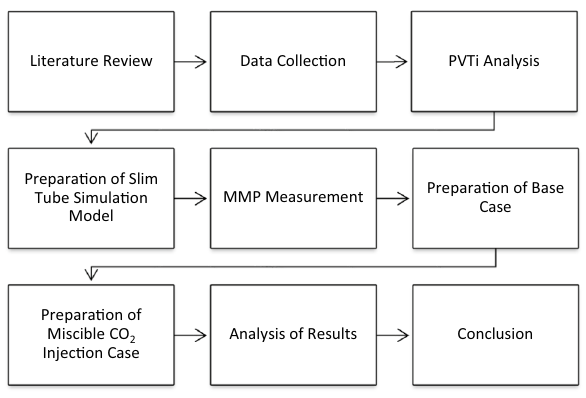
Fig. 1 Miscible CO 2 displacement process